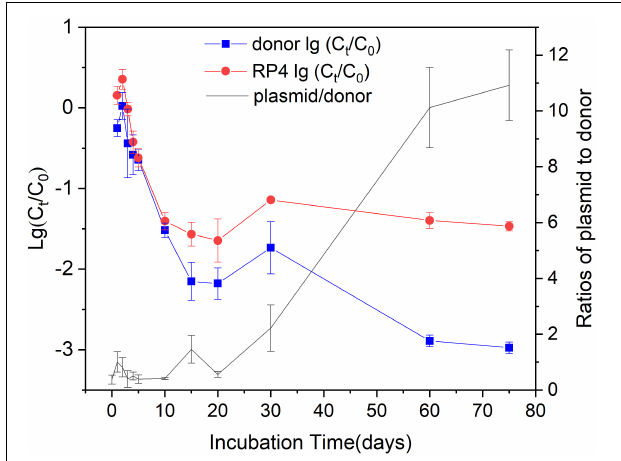
FIGURE 1 | The decay of the donor and plasmid during incubation. Log values of the ratios of donor (plasmid) concentration at time t to the initial concentration were shown on the left Y -axis. The donor and plasmid concentrations were represented by the copy numbers of dsRed and gfp gene, respectively. The right Y -axis showed the ratios of plasmid RP4 to donor. Error bars represent standard error (SE) of sampling replicates on each time point ( n = 3 or